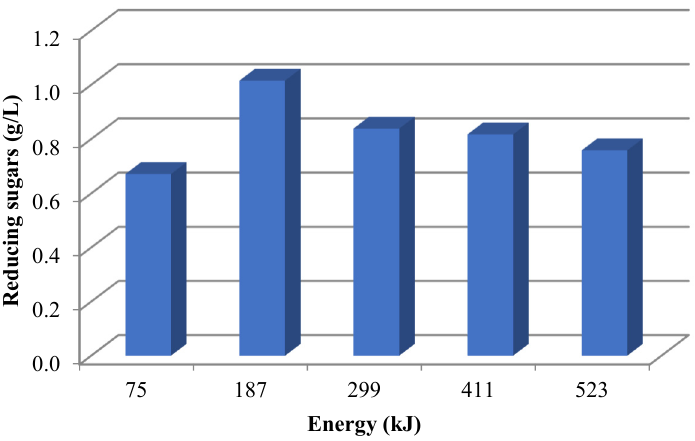
Figure 3. Influence of consumed energy on reducing sugars.